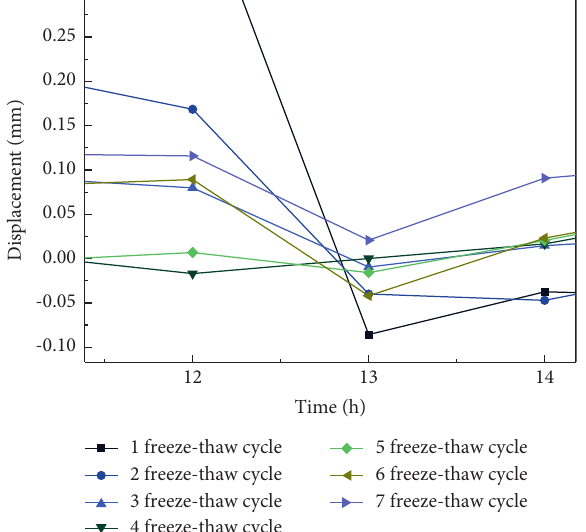
Figure 9: Curve of displacement and deformation (local magni- fication in 12–14h).